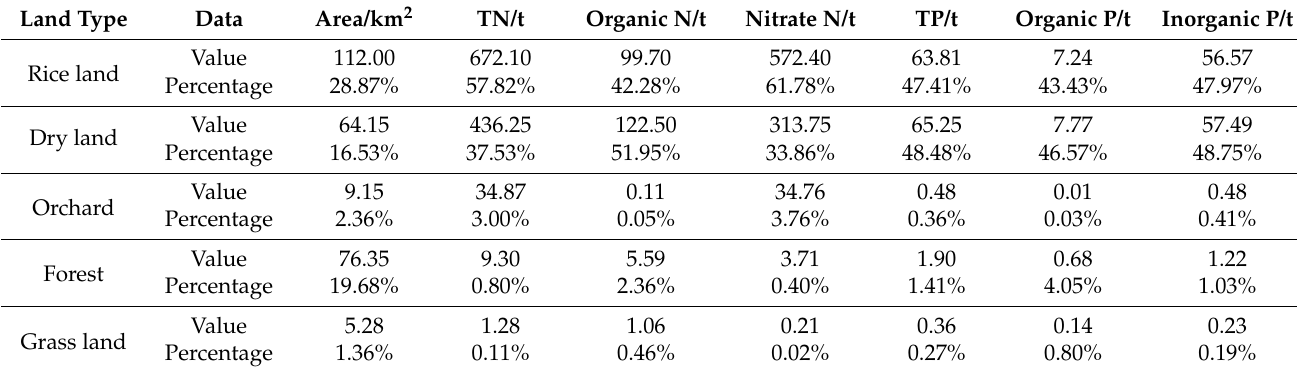
Table 4. Nutrient loss of different types of farmland in MLW.